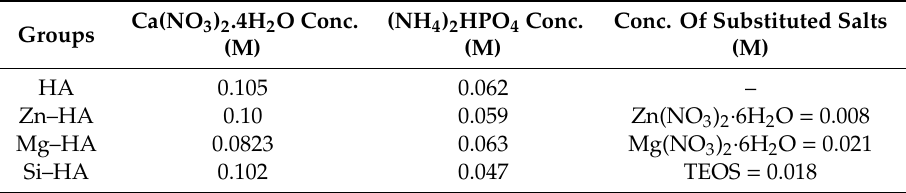
Table 1. Concentration of precursors used in syntheses of hydroxyapatite (HA), Zn–HA, Mg–HA, and